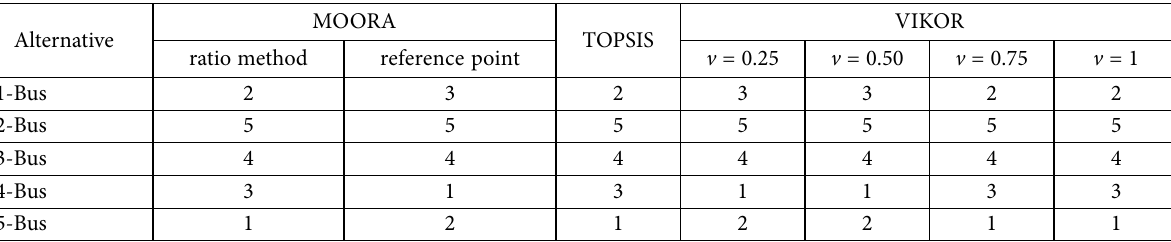
Table 7. Ranking of the alternatives for each method